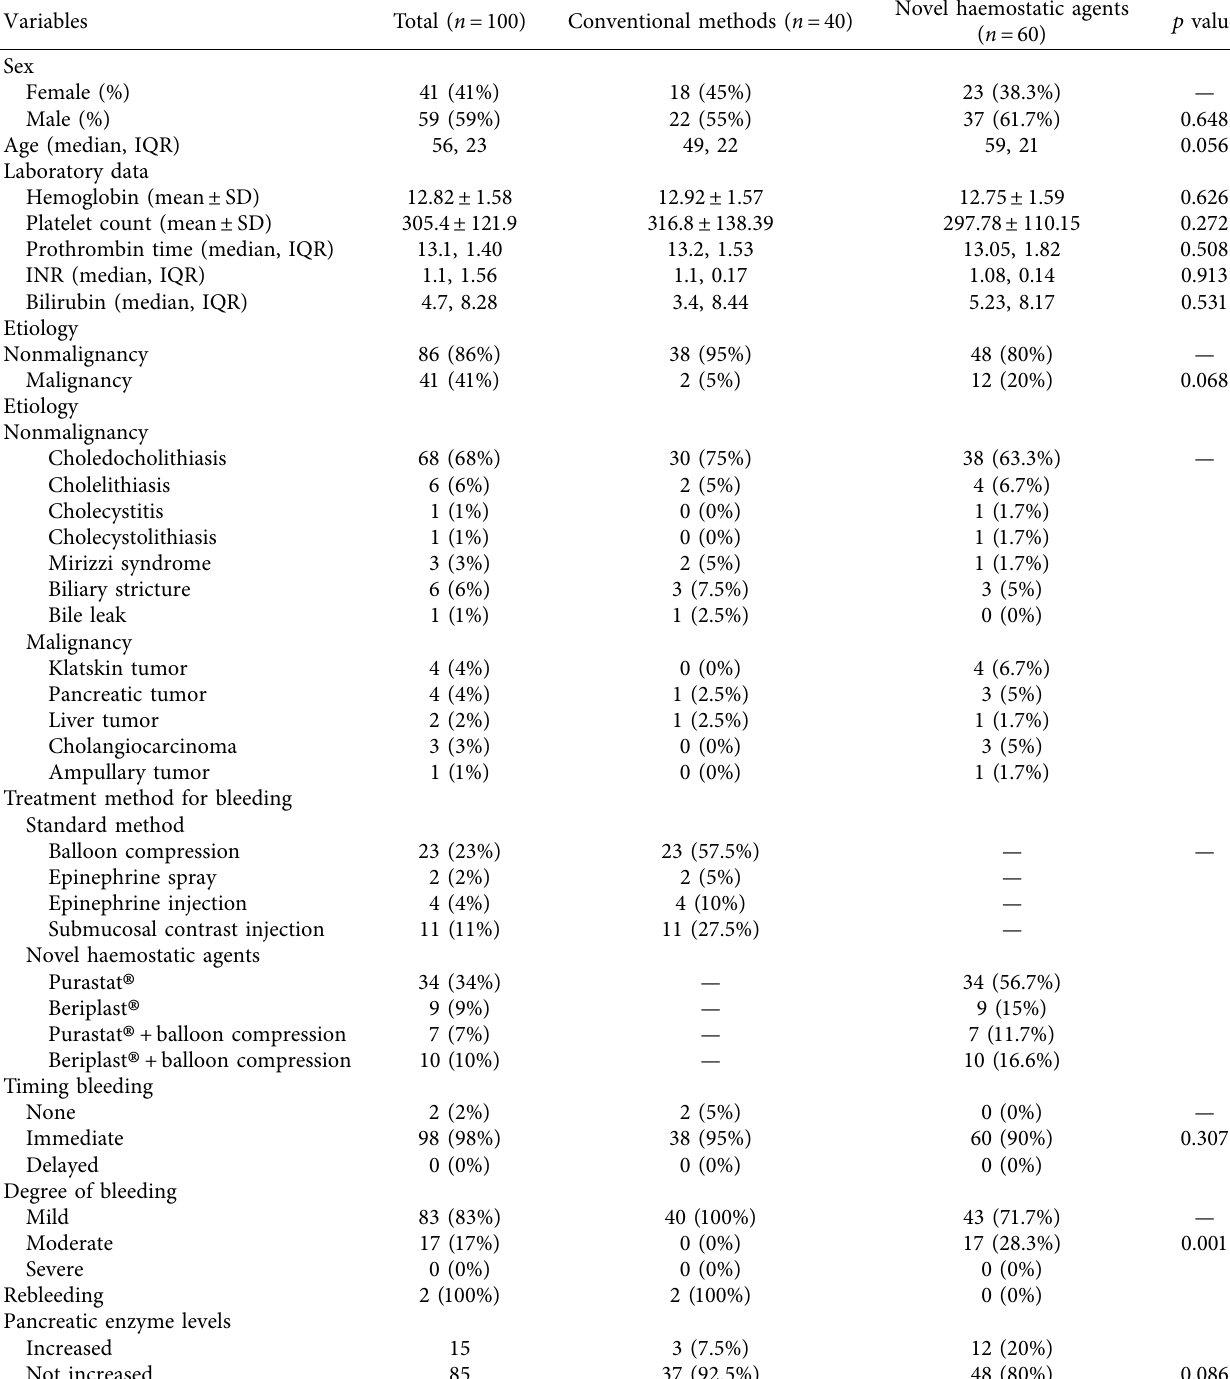
Table 1: Characteristic comparison between conventional methods and novel haemostatic agents